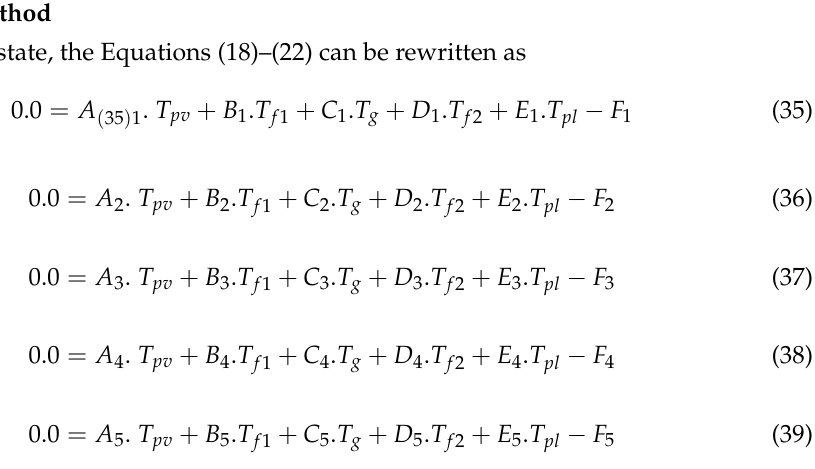
Figure 3. Exergy PV/T Model.